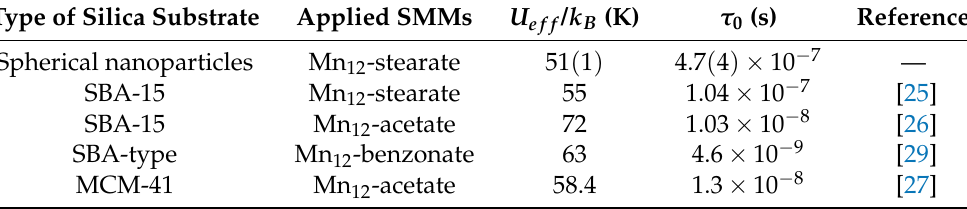
Table 2. Relaxation parameters derived from AC susceptibility measurements for Mn 12 -based SMMs organized on different nanostructured silica